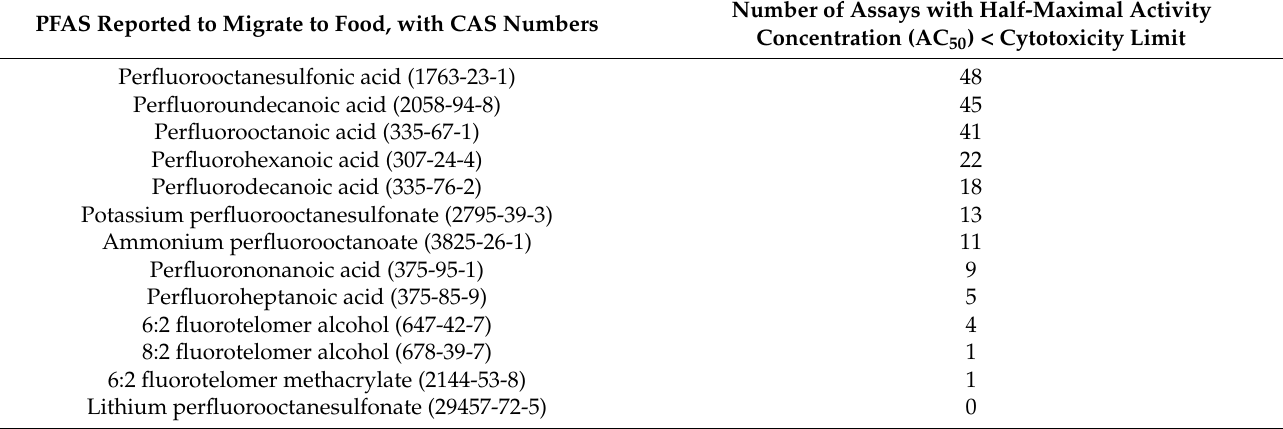
Table 1. Number of ToxCast assays for per- and polyfluoroalkyl substances (PFAS) with the half-maximal activity concen- tration (AC 50 ) below the cytotoxicity limit.